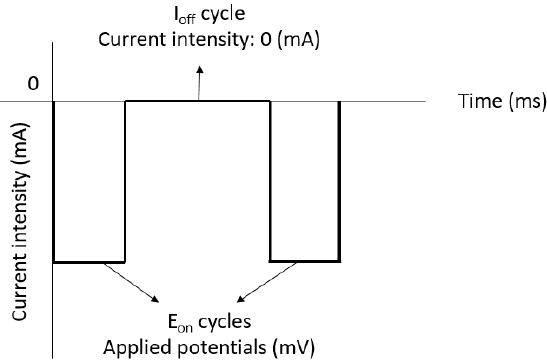
Figure 9. Pulsed deposition waveform.